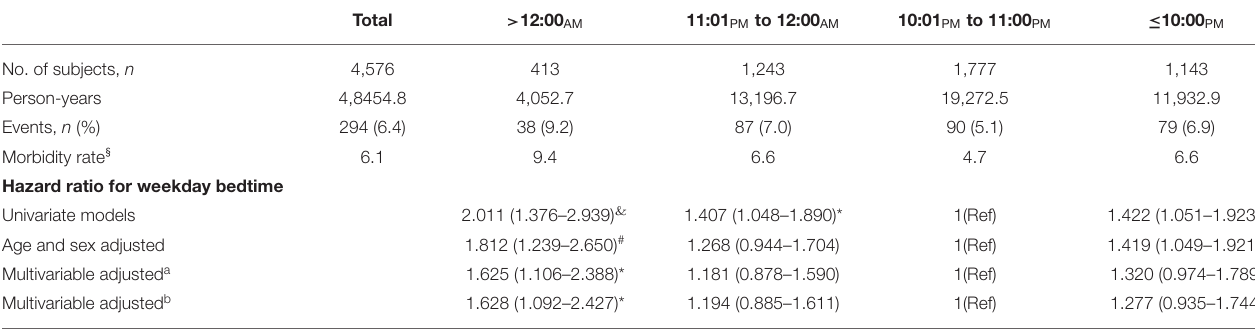
TABLE 2 | Hazard ratios and 95% CIs for bedtime associated with MI on